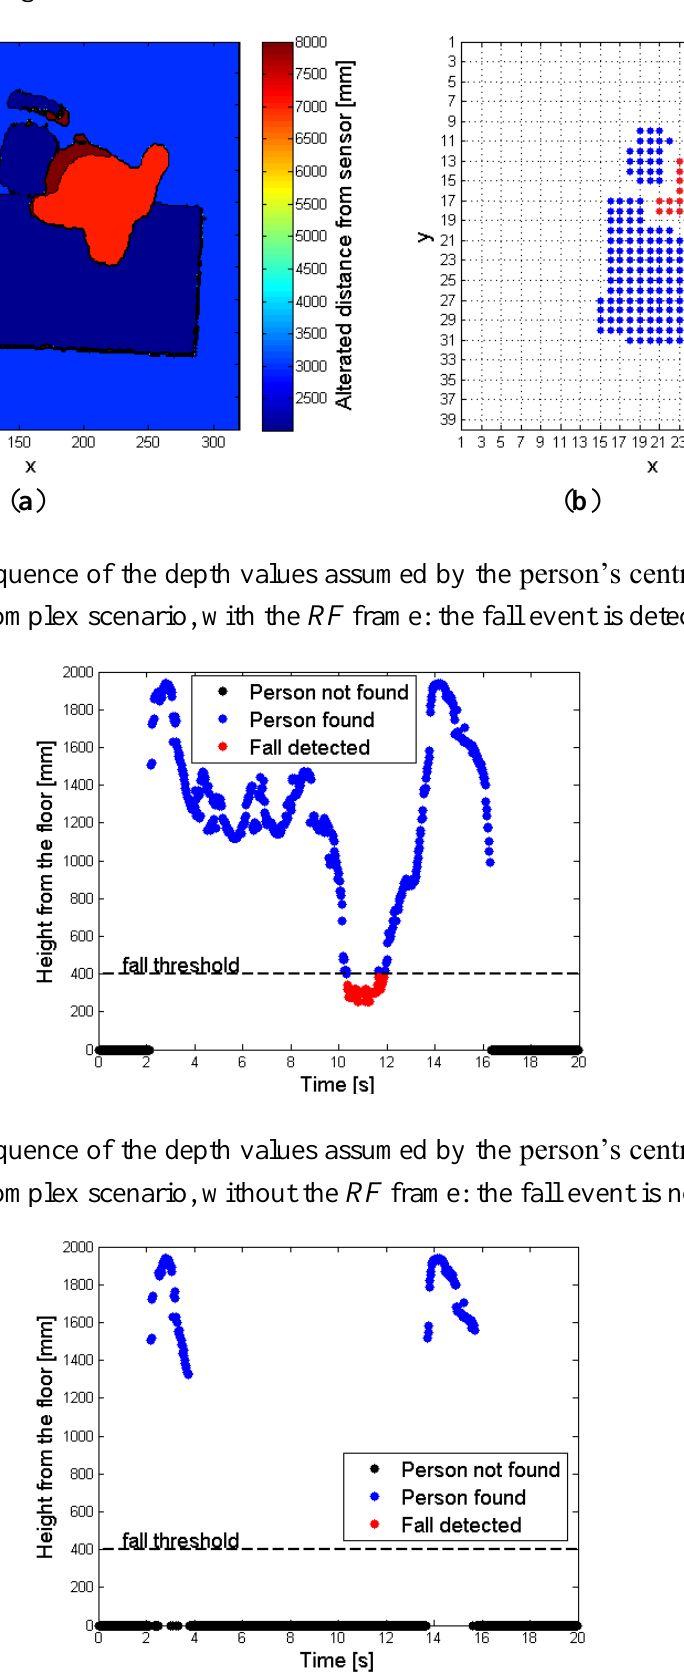
Figure 12. Complex fall with object interaction: ( a ) preprocessed frame, ( b ) corresponding FF frame, when the algorithm uses the RF.